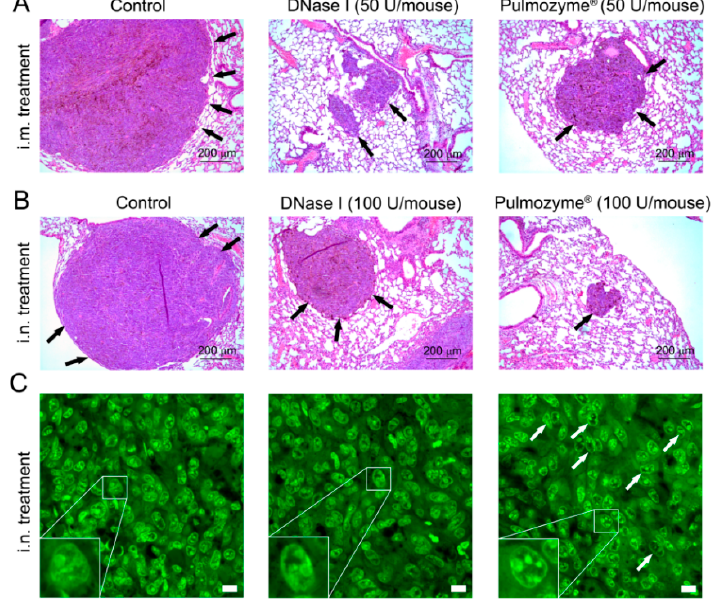
Figure 4. Representative images of B16 melanoma metastases in the lungs of tumor-bearing mice without treatment (control) and after i.m. and i.n. administration of Pulmozyme ® and DNase I. ( A , B ) Metastases in lungs in intramuscular ( A ) and intranasal ( B ) experiments. Hematoxylin and eosin staining, light microscopy, original magnification ×100. Black arrows indicate metastatic foci in the lungs. ( C ) SYTO TM staining, confocal fluorescent microscopy using a plan-apochromat 63×/1.40 Oil DIC M27 objective. Scale bar corresponds to 10 μ m. White arrows indicate B16 melanoma cells with disrupted structural organization of nuclei. Typical examples of B16 cells with condensation and parietal localization of chromatin are shown in the bottom left corner.